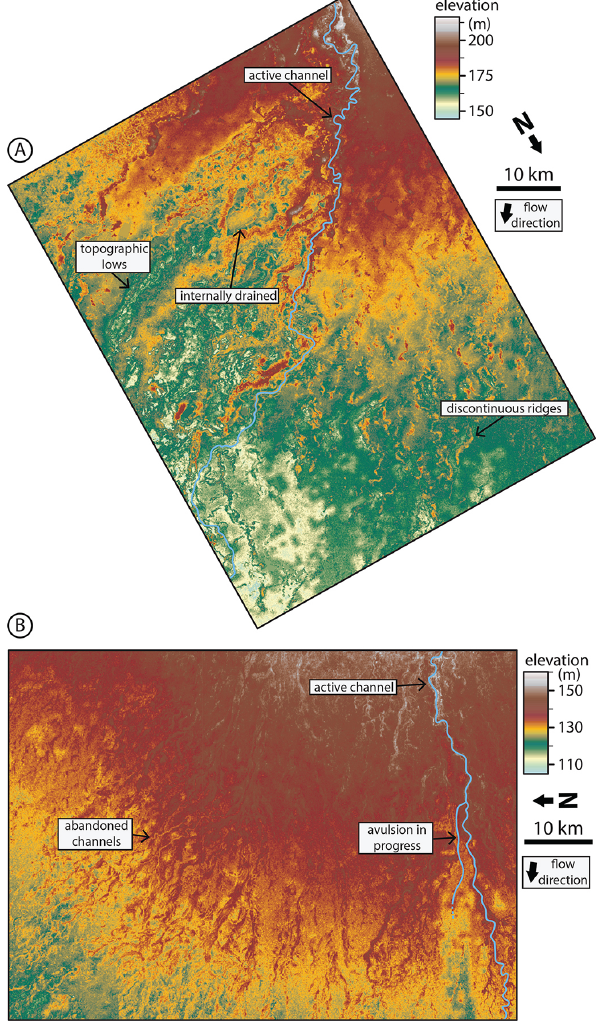
Figure 2. Bare-earth digital elevation models (O’Loughlin et al., 2016) of floodplain topography on the Maniqui (a) and Taquari (b) megafans. Locations are shown in Fig. 1. Floodplains are densely channelized by abandoned channels with visible topographic highs and lows corresponding to levees or alluvial ridges and chan- nel beds, respectively. Note the presence of discontinuous alluvial ridges. Also note that the color bar is not perceptually uniform, meaning that small changes in certain elevation ranges are high- lighted more drastically than others; this is done to emphasize low- relief features relative to the overall fan